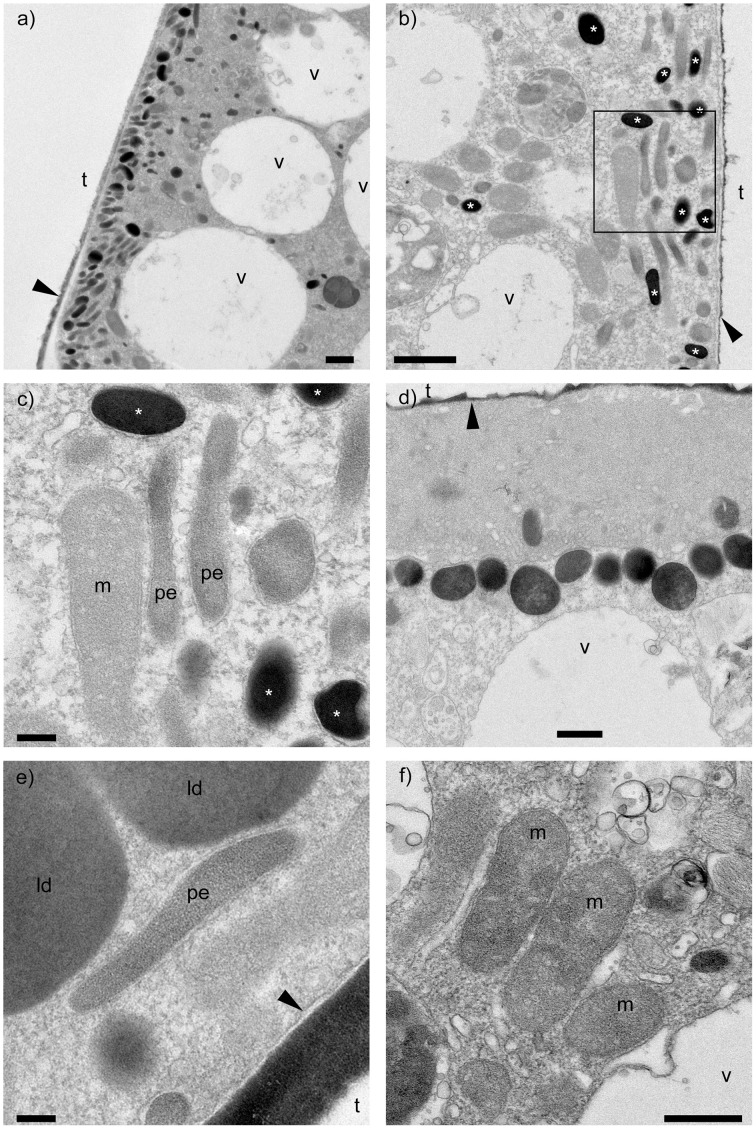
Transmission electron micrographs of Ammonia sp. incubated with anoxic conditions. (A,B) Clusters of electron dense bodies (*) found near the cell periphery of the antepenultimate and penultimate chambers, respectively. (C) Close-up view of outlined area in b showing electron dense bodies (*), most bound by membrane. (D) Electron dense bodies showing heterogeneous electron densities. (E) Close-up view of a possible endobiont surrounded by membrane. (F) Mitochondria showing double exterior membrane. m, mitochondria; pe, possible endobionts; v, vacuoles; t, test (former location); ld, lipid droplet; black arrows, organic lining. Scale bars: (A,B) = 1 μm; (C,E) = 200 nm; (D,F) = 500 nm. Panels (A–C,F): anoxic specimen A; panels (D,E): anoxic specimen B.